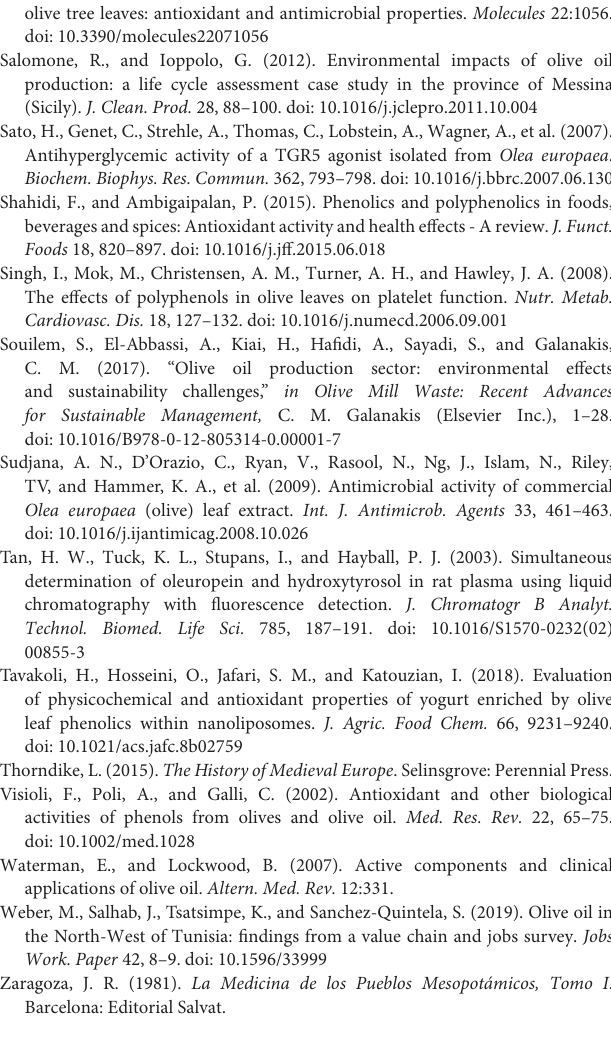
table olive and olive oil industry: a review. J. Sci. Food Agric. 98, 1271–1279. doi: